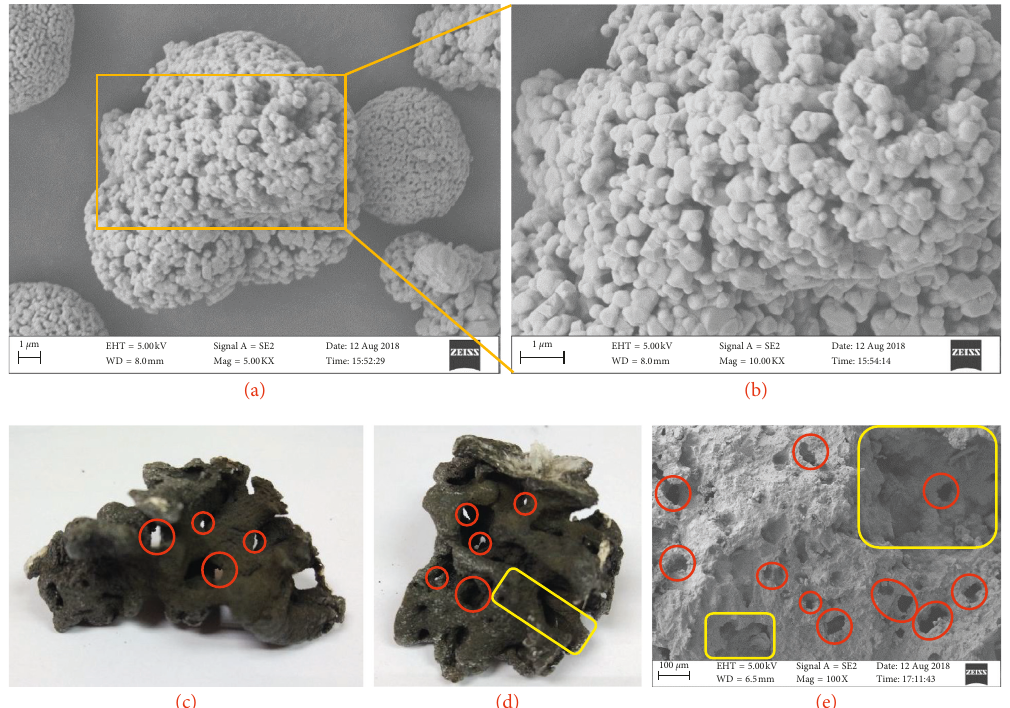
Figure 10: The macroscopic and microscopic morphology of the oxygen candles before and after combustion. Microscopic morphology of cobalt(II,III) oxide (a) and its local enlargement (b) by SEM; macroscopic morphology of the oxygen candles after combustion (c, d); microscopic morphology of fresh section of the oxygen candles after combustion (e) by